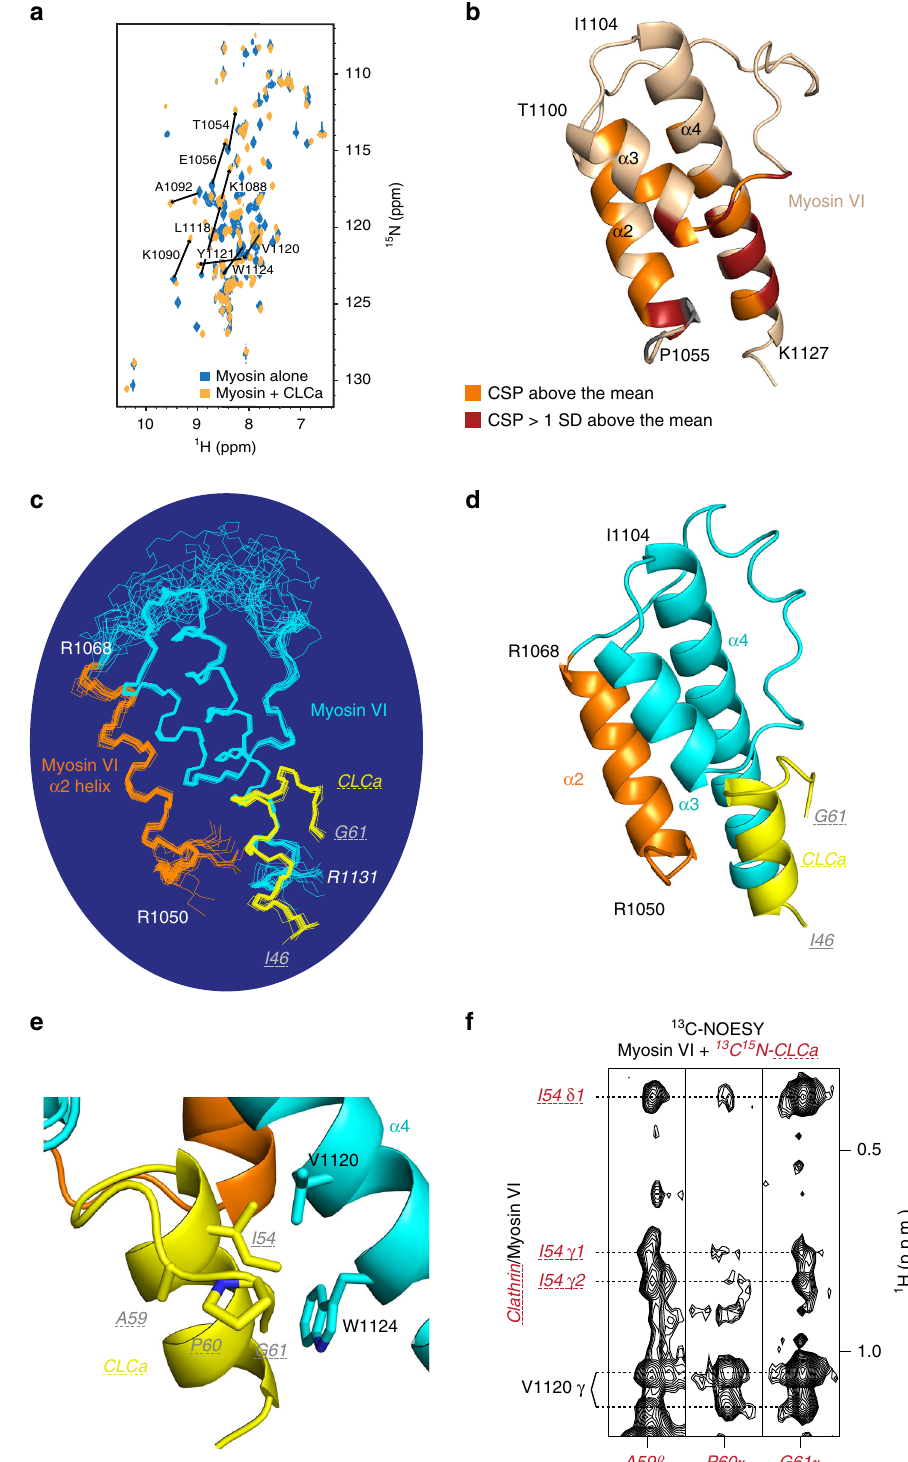
L55-G58 forms a helical turn with A59-G61 folding back along one side of the CLCa α -helix (Fig. 3e), a structure supported by NOEs to CLCa I54 and to myosin VI α 4 (V1120 and W1124, Fig. 3f and Supplementary Fig. 7c, e). The hydrophobicity of CLCa A59 and P60 likely drives this segment to remain in close contact with the helices (Fig. 3e), as supported by the NMR data (Fig.